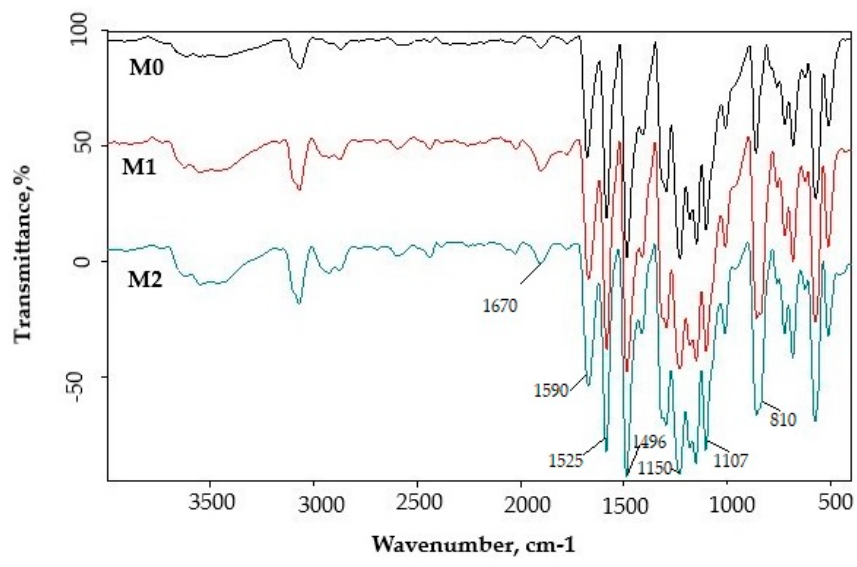
Figure 7. FTIR spectra of PPEES (M0) and PPEES with silica nanoparticles (M1 and M2). The FTIR spectrum of PPEES and PPEES with silica nanoparticles membrane displayed following results: (a) peaks at 810 cm − 1 was assigned to Si-O-Si vibration and 960 cm − 1 was assigned to Si-O stretching vibration of SiOH group corresponding to KIT-6, and KIT-6-NH 2 appears only on the M1 and M2 membranes; (b) 1107–1072 cm − 1 was attributed to the aromatic ring vibrations; (c) 1150 cm − 1 corresponded to the symmetric O=S=O stretching of sulfone group; (d) 1230 cm − 1 was attributed to the aromatic ether and 1323 cm − 1 was attributed to the S=O stretching in sulfone; (e) 1412 cm − 1 corresponded to asymmetric C-H bending deformation of methyl group; (f) 1525 cm − 1 (N-H bending) indicated the presence of -NH 2 groups in amino silica; (g) 1590 cm − 1 was attributed to the C=C aromatic ring vibrations; (h) the band at 1670 cm − 1 correlated with C=O stretching, which might indicate the existence of PVP in the matrix; and (i) 3600–3400 cm –1 corresponded to O-H stretching vibrations.